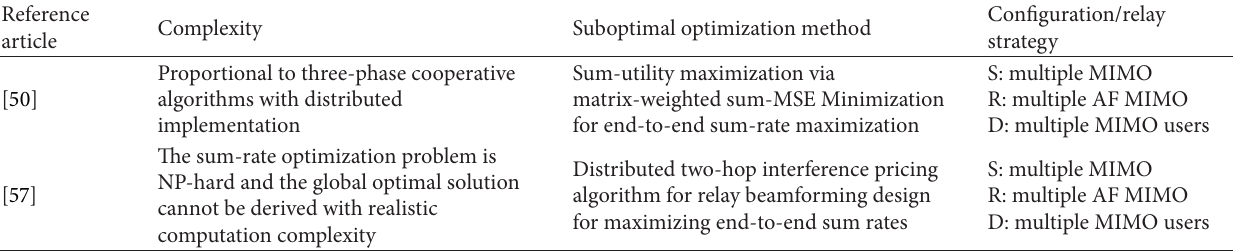
algorithm for relay beamforming